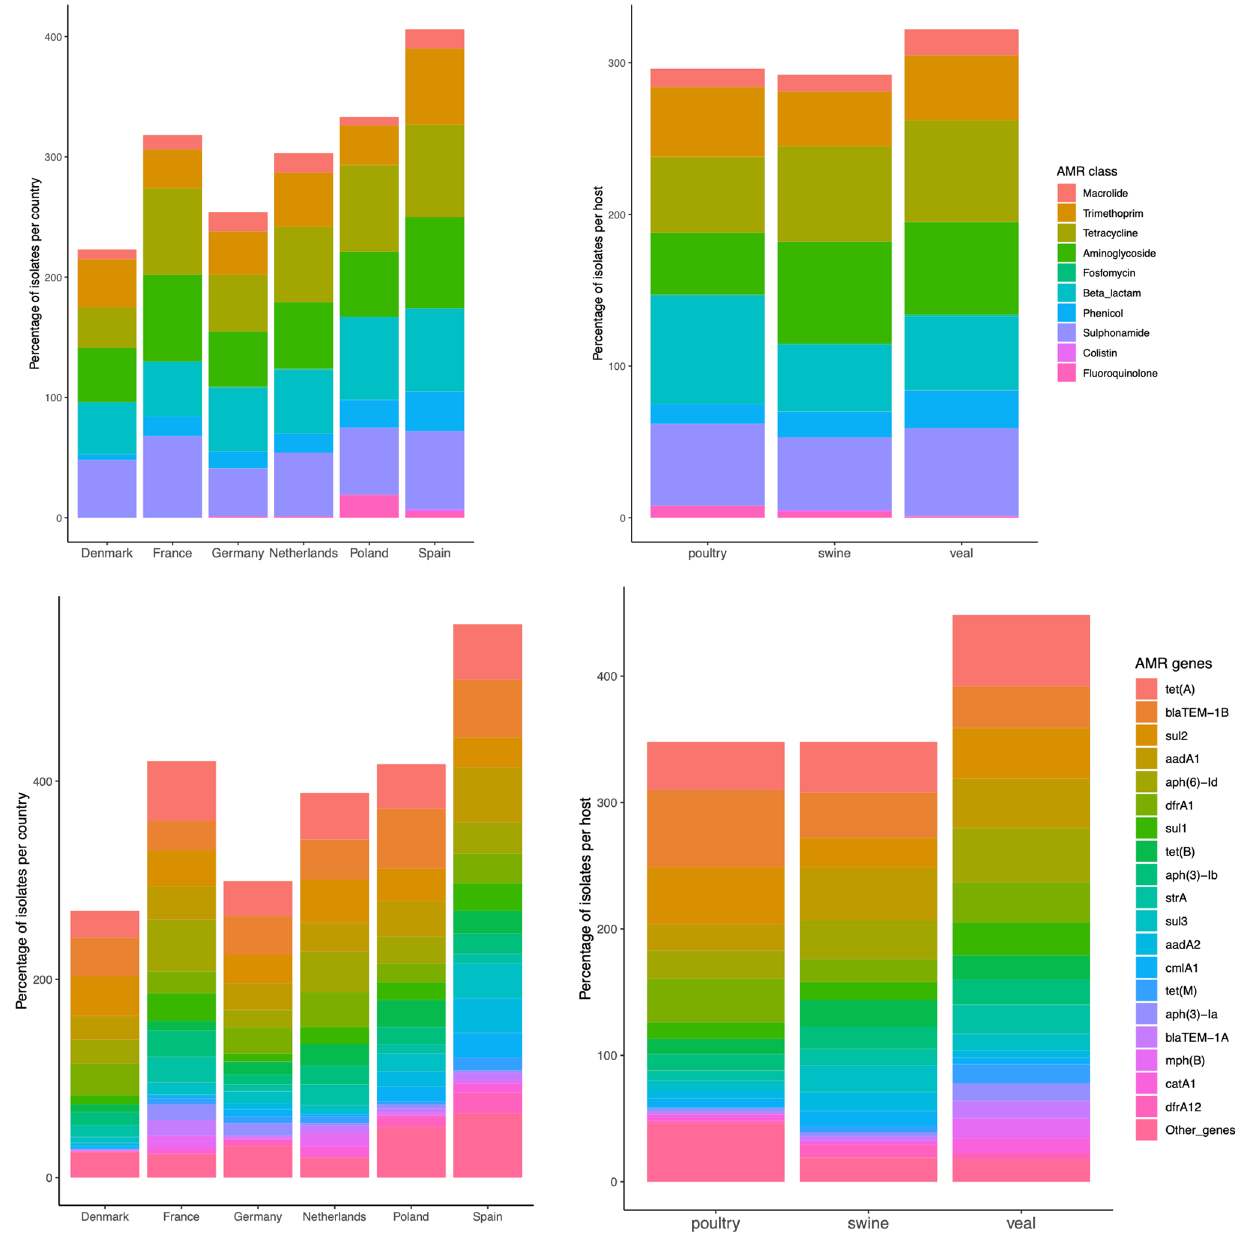
Figure 3. Bar plot showing percentage of resistant E. coli isolates in AMR classes (top) and genes (bottom) stratified by country (left) and host